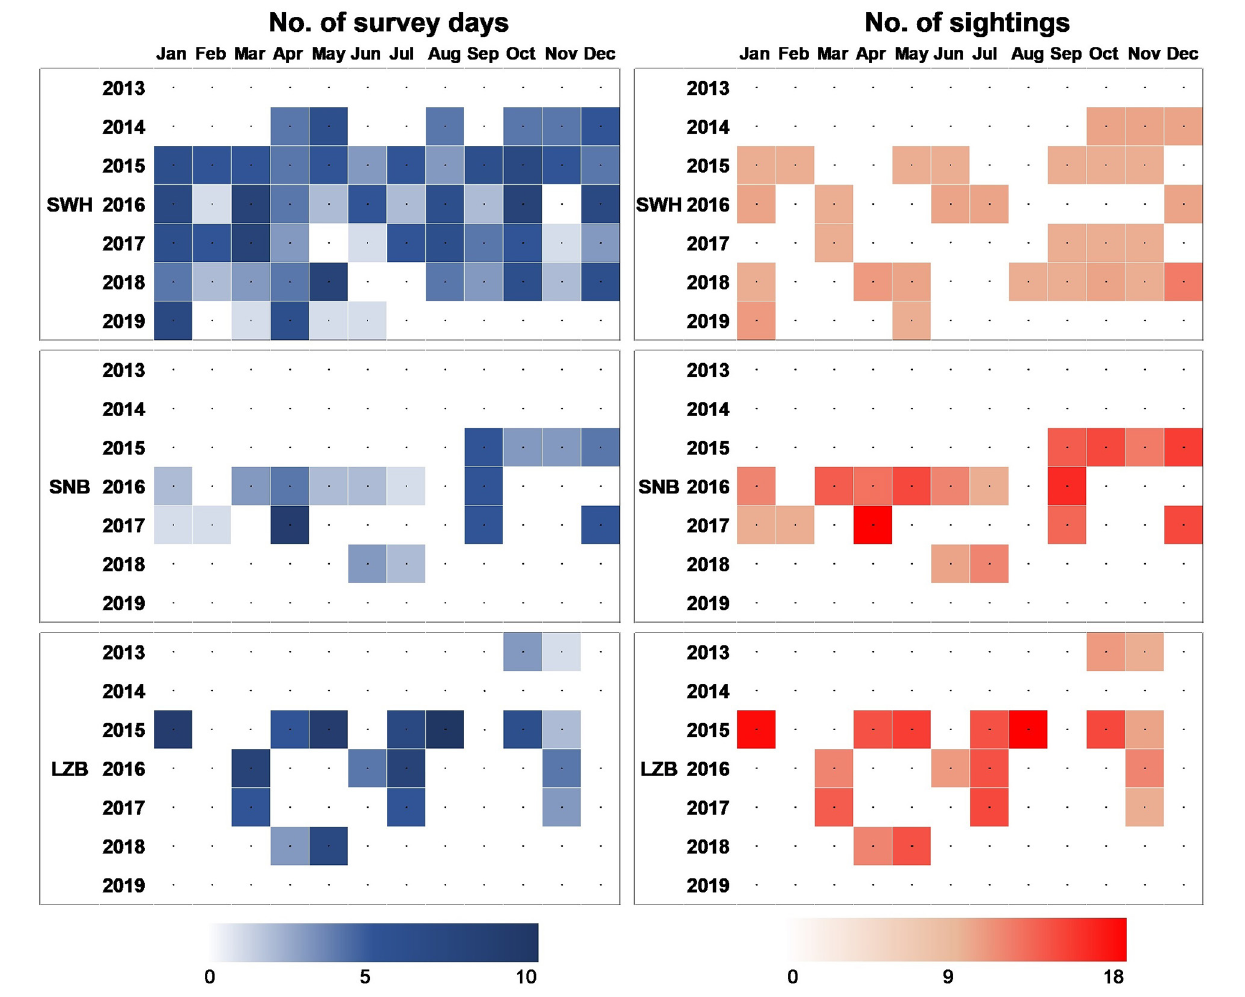
FIGURE 2 | A colorful matrix plot to show number of survey days and humpback dolphin sightings per month from 2013 to 2019 in three survey areas: SWH, SNB, and LZB.